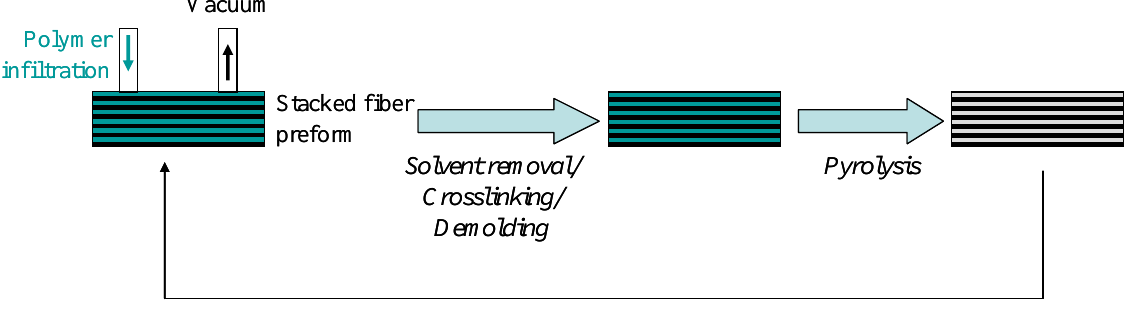
Figure 8. Polymer infiltration pyrolysis (PIP) to prepare fiber-reinforced ceramic matrix